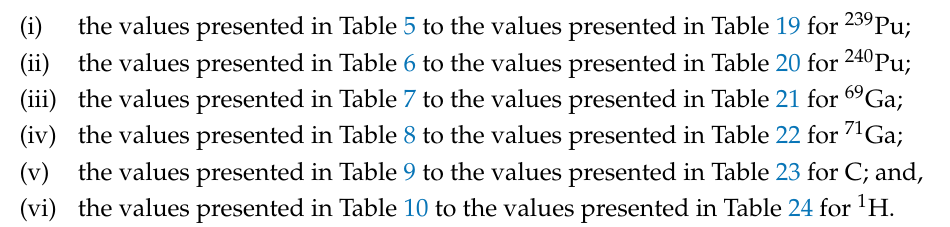
(cid:16) (cid:17)(cid:16) (cid:17) ∂ L / ∂σ g σ g / L , g = 1, ... ,30 and c , i = 6 c , i = 6 (cid:16) (cid:17)(cid:16) (cid:17) ∂ 2 L / ∂σ g ∂σ g σ g σ g / L , g = 1, ... ,30, to the capture cross c , i = 6 c , i = 6 c , k = 6 c , k = 6